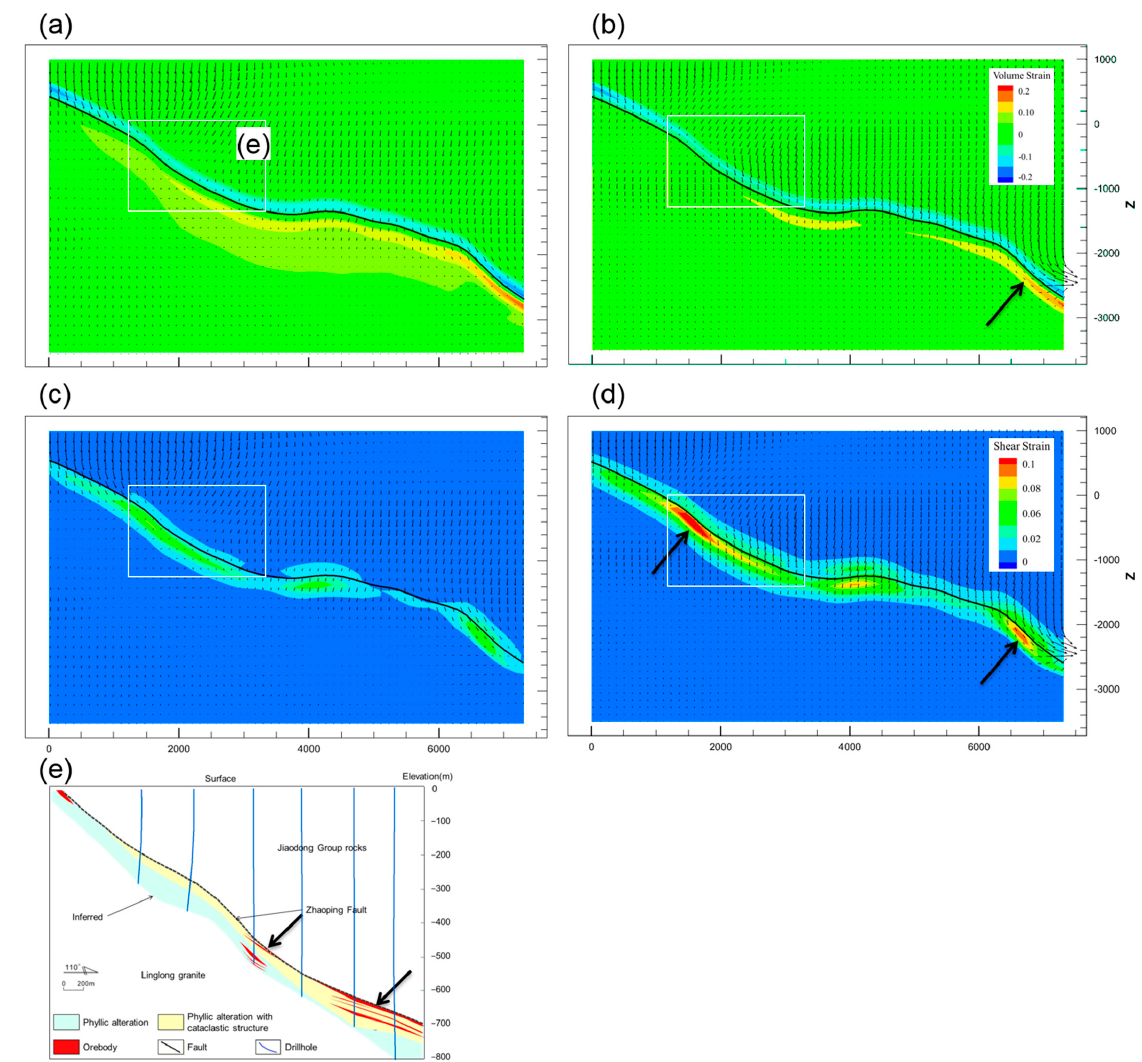
Figure 8. The volumetric strain, shear strain distribution, and detailed fluid flow vectors at a strain rate of 10 − 11 s − 1 . In the figure, the rectangular box is the scope of the cross-sections; thick arrows indicate areas of intense strain or mineralization; the vector arrows represent the Darcy flux and are used to indicate the direction of flow. ( a ) 0.5% volumetric strain, ( b ) 1.0% volumetric strain, ( c ) 0.5% shear strain, ( d ) 1.0% shear strain, and ( e ) corresponding geological